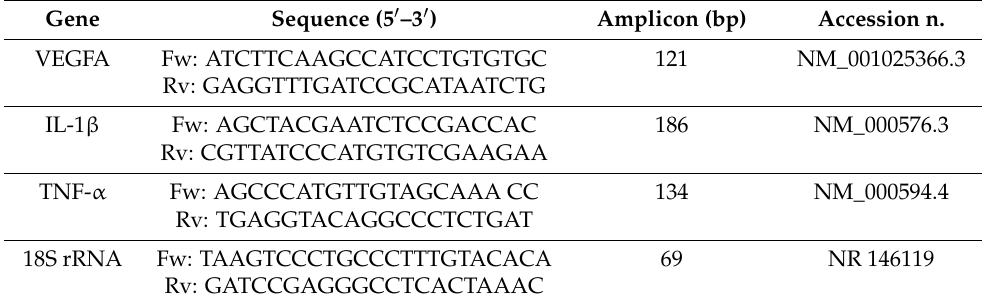
Table 1. Primers sequences that were used for quantitative